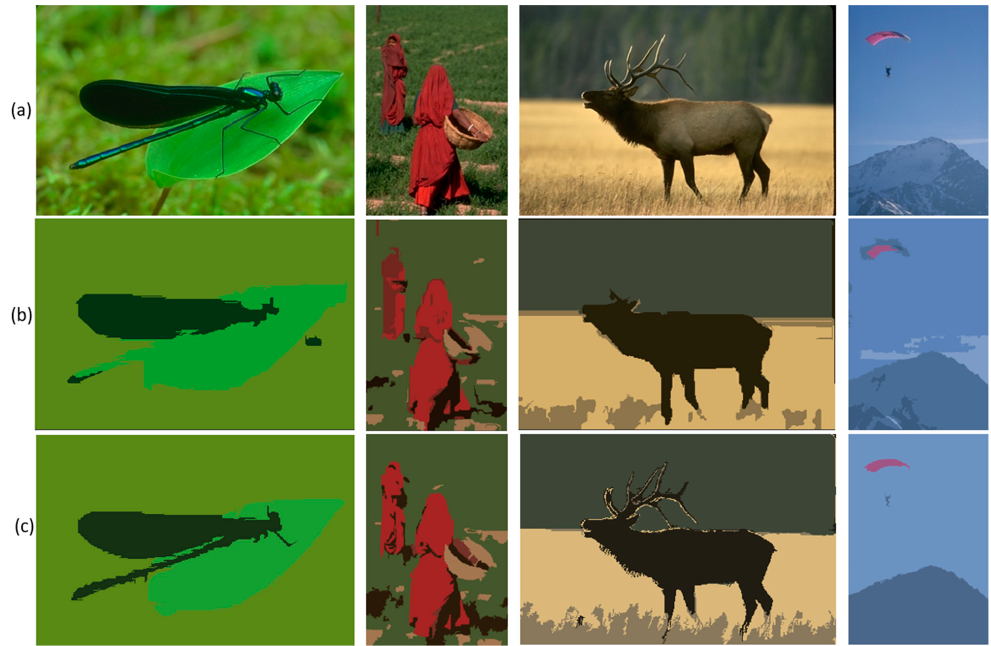
Figure 7. Comparison of segmentation results with and without contrast and texture enhancement (CTE). From top to bottom: ( a ) Original images, ( b ) w / o CTE-block some parts of the objects get wrongly classified as the background (e.g., insect’s tail, woman’s hand and basket, deer’s antlers, and man with parachute), moreover, the boundaries of the segmented regions are not sharp, ( c ) w CTE-block, the insect’s tail, deer’s antlers and man are properly segmented.